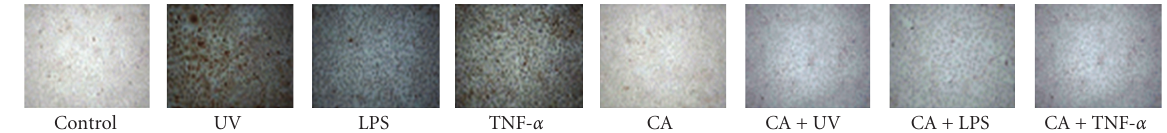
Figure 3: Immunostaining for hBD was more intense on LPS, TNF- α treated, and UV irradiated groups than in the normal control. In the additional groups treated with calcipotriol for hBD, the results were less intense than the stimulant groups.